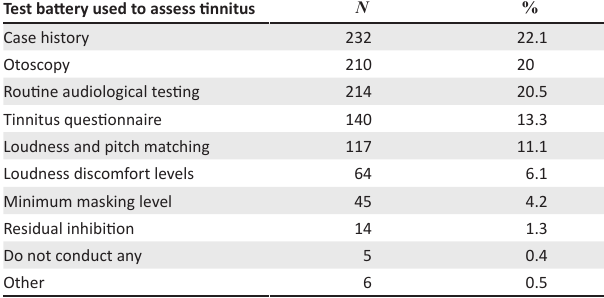
TABLE 4: Test battery used to assess tinnitus. Test battery used to assess tinnitus